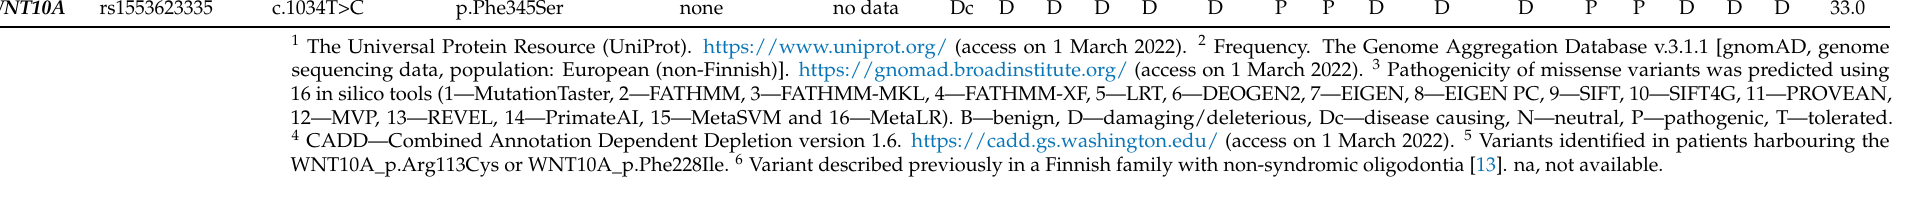
Table 3. Dental phenotype of patients with variants identified in genes other than WNT10A